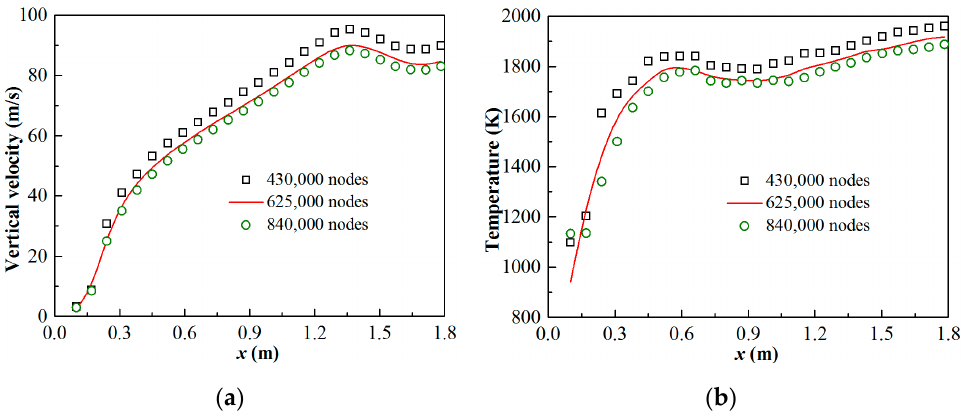
Figure 3. Grid independence test along the axis. ( a ) Velocities, ( b ) gas temperature.